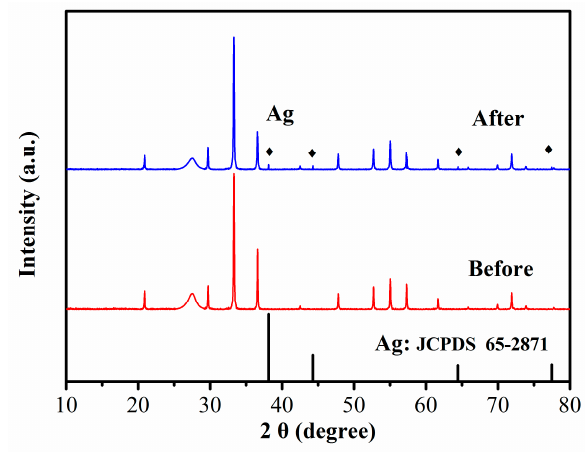
Figure 10. XRD patterns of Ag 3 PO 4 /g ‐ C 3 N 4 (30%) before and after the photocatalytic reaction.